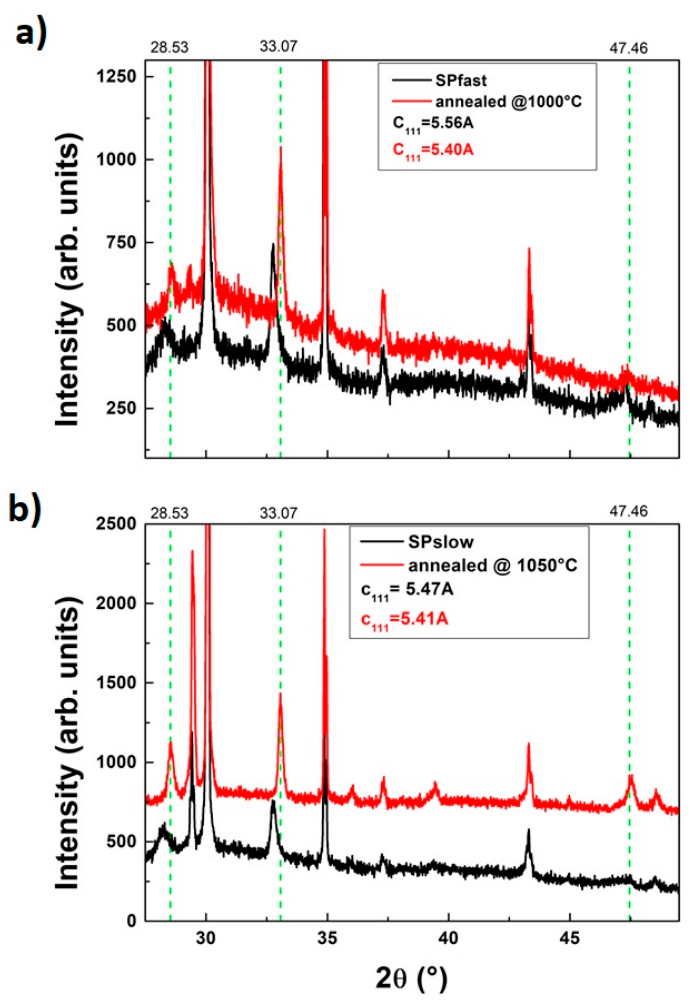
Figure 2. XRD profiles and estimated axis values along the growth direction of all the samples (SPfast in ( a ) and SPslow in ( b )) analyzed in the present study; curves are shifted for clarity. As grown samples XRD are plotted with black lines, while annealed samples are plotted with red lines. The green dashed lines and numbers on top axis show GDC bulk values found in the literature [15].